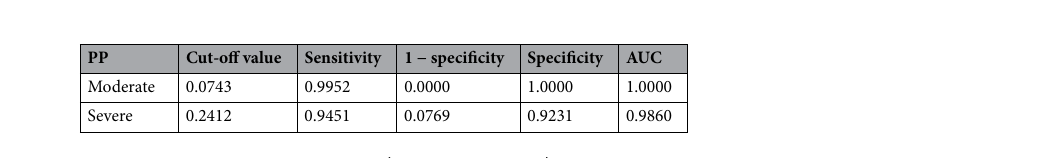
Table 5. Threshold definition for |ln(Q4Q2/Q3Q1)|.